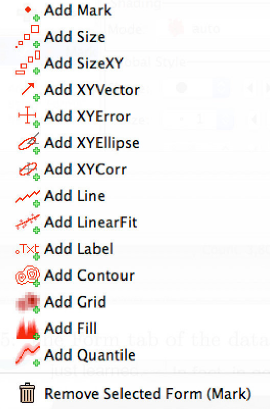
Fig. 70.— The Form dropdown menu While TOPCAT does not provide for general fitting, it can be used to produce a linear fit. To this end, proceed as in section 4.5 in order to select the cluster’s main se- quence stars as a subset. Display only that subset. With the data set selected, go on the “Form” tab, click on the big green cross to add a new form. The dropdown menu is shown in Fig. 70. From that dropdown menu, select “Add LinearFit”. TOPCAT will fit a line to your data points, and when you select the LinearFit form and scroll down, it will show you the best-fit parameters it has chosen, as well as the correlation, cf. Fig. 71. Note that, for TOPCAT, both the data point representation (“Mark”) and the linear fit (“LinearFit”) are merely dif- ferent forms of representing the same data. Other forms, including more complex ones like XY error bars or el-